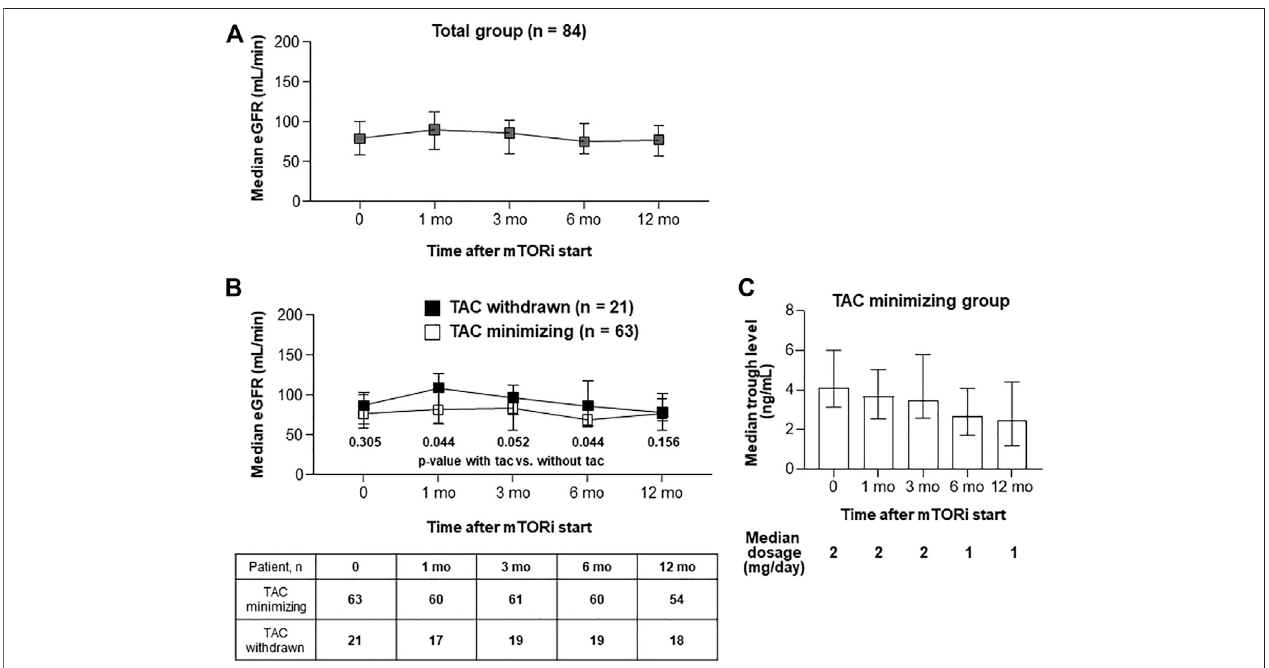
FIGURE3 | SerialrenalfunctionsaftertheintroductionofmTORinhibitors. (A,B) GraphsshowmedianwithIQRofGFRlevelineachgroupSerialGFRintotalpatients (A) . Serial GFR in patientswith TAC ( n (cid:1) 63) or without TAC ( n (cid:1) 21). Comparing GFR levels between TAC withdrawn and with TAC minimizing groups, Mann-Whitney test was used (B) . (C) A graph that shows (1) median dosage of TACs after mTOR inhibitors start, and (2) median with IQR of tacrolimus trough levels at each